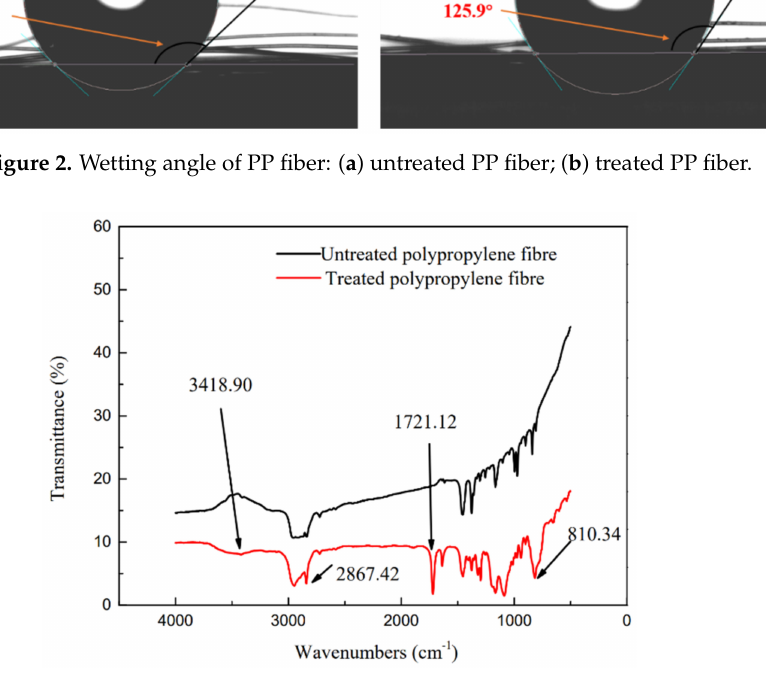
Figure 3. Infrared spectra of treated and untreated PP fibers.